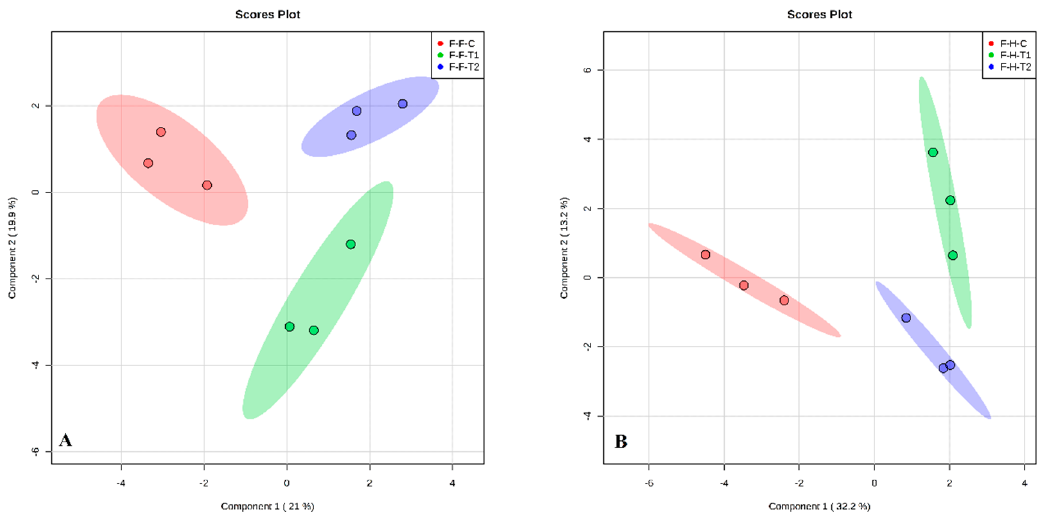
Figure 6. Principal component analysis (PCA) model obtained from the classification of volatile organic compounds emitted from the flowers of Floribunda ( A ) and Hybrid Tea ( B ), based on VOCs according to NAA treatments. F and H represent Floribunda and Hybrid Tea, respectively. While C (control) (red), T1 (100 mg/L) (green) and T2 (200 mg/L) (blue) represent 0, 100 and 200 mg/L NAA, respectively. Three dots in each group represent n = 3 biological replicates.